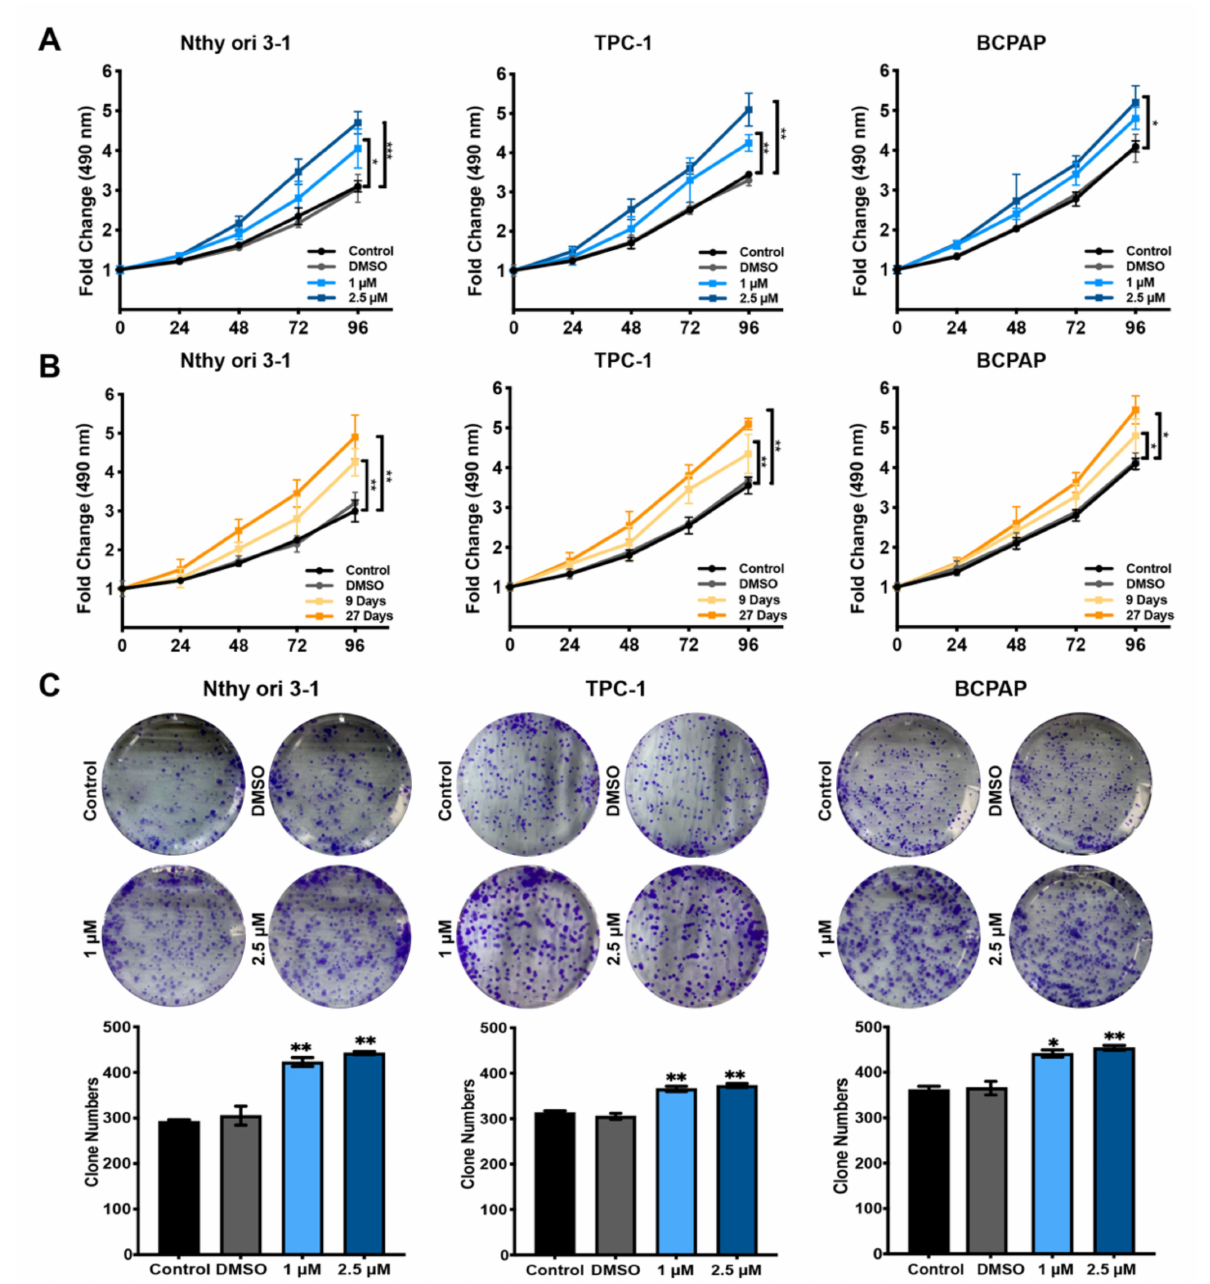
Figure 1. Hormesis effect of BDE209 on Nthy-ori 3-1 and PTC cell proliferation. ( A ) Cell viability in the indicated cell lines and concentration was assessed by MTS assays, and the results were calibrated to time 0. ( B ) Cell viability was measured in the indicated cell lines under decabromodiphenyl ether (BDE209) treatment by MTS assays. Nthy-ori 3-1, TPC-1, and BCPAP cells were treated with 2.5 µ M BDE209 for 9 and 27 days. The DMSO group of each cell line was treated with DMSO at a concentration of 2.5 µ M for 27 days. ( C ) Colony formation assay of the indicated cells treated with BDE209 or DMSO. * p < 0.05, ** p < 0.01, *** p < 0.001 based on Student’s t -test. The data shown are the means ± SD of triplicate wells and are representative of at least three replicate